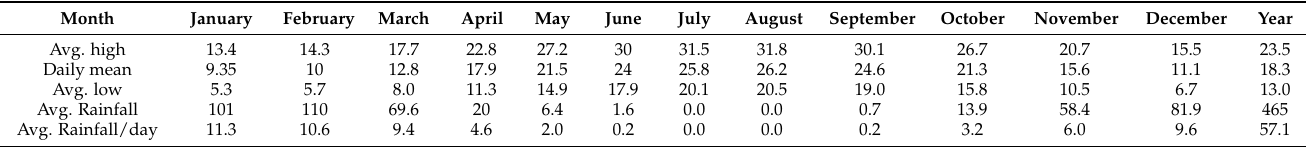
Figure 1. Location map of Irbid District and True Color Composite Images Landsat-5 (1985 and 2004) and Landsat-8 (2013 and 2021). Table 1. Climate data for Irbid, Rainfall mm, temperature °C [27]. Table 1. Climate data for Irbid, Rainfall mm, temperature ◦ C [27].